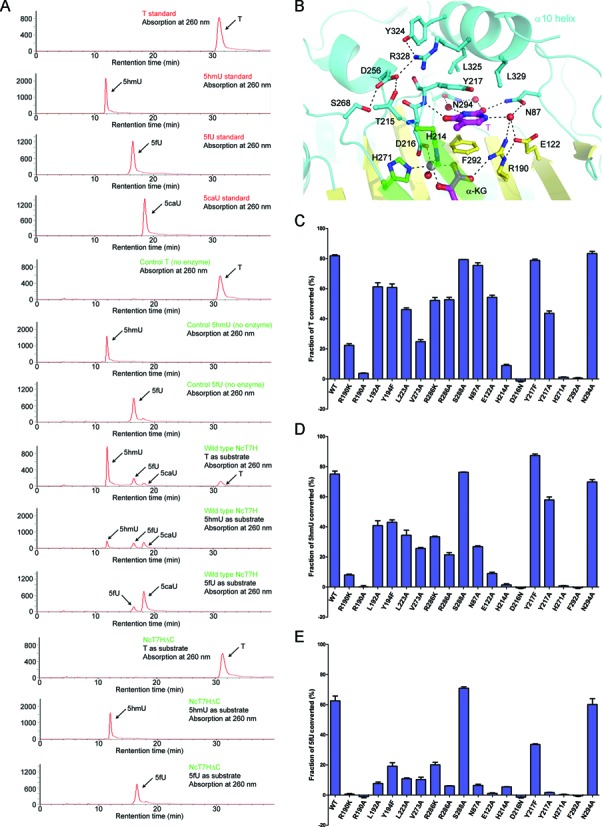
Apparent enzymatic activities of wild-type and mutant NcT7H. (A) Activities of the full-length of NcT7H and the C-terminal truncated NcT7HΔC for the oxidation of T, 5hmU and 5fU analysed with the HPLC method. The standard T, 5hmU, 5fU and 5caU were used as references. (B) Interactions of the α10 helix with the residues composing the active site in the structure of NcT7H-T complex. The key residues, the substrate and α-KG are shown with ball-and-stick models. The hydrogen bonds are indicated with black dotted lines. (C–E) The effects of mutations of the key residues at the active site on the apparent enzymatic activity for the oxidation of (C) T, (D) 5hmU and (E) 5fU, respectively.